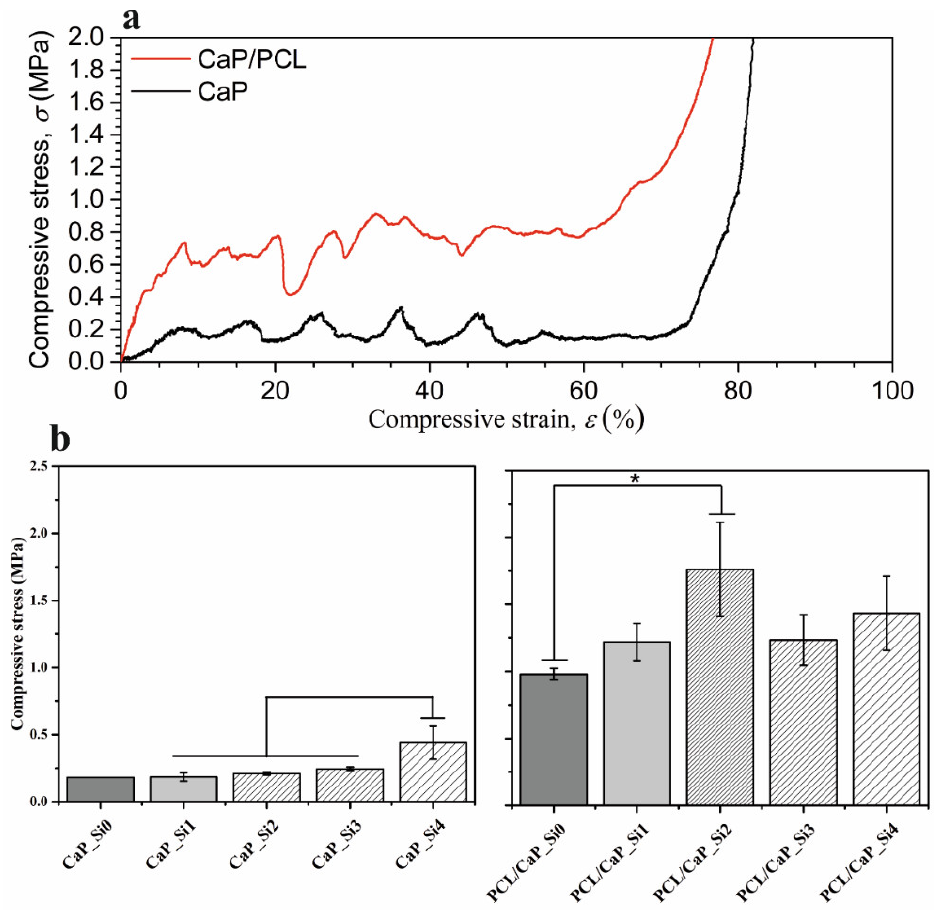
Figure 7. Typical compressive stress–strain curves for CaP_Si0 and composite PCL/CaP_Si0 scaffolds ( a ). Compressive stress of all prepared scaffolds ( b ). The significant difference between two groups (*): p < 0.05.